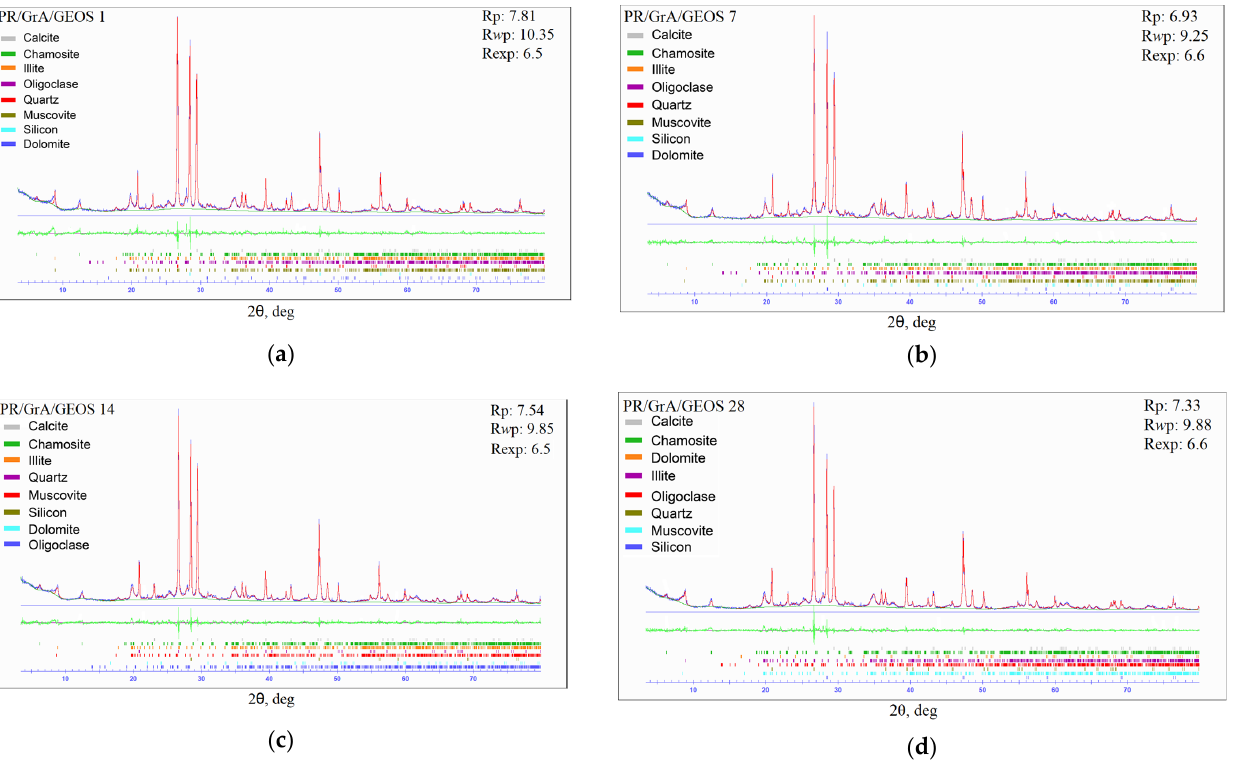
Figure 5. XRPD patterns refined by means of the Rietveld method for PR/GrA/OLA samples after 1 ( a ), 7 ( b ), 14 ( c ), and 28 ( d ) days of curing with the addition of the external standard (crystalline silicon—Si). See Figure 3 for details.